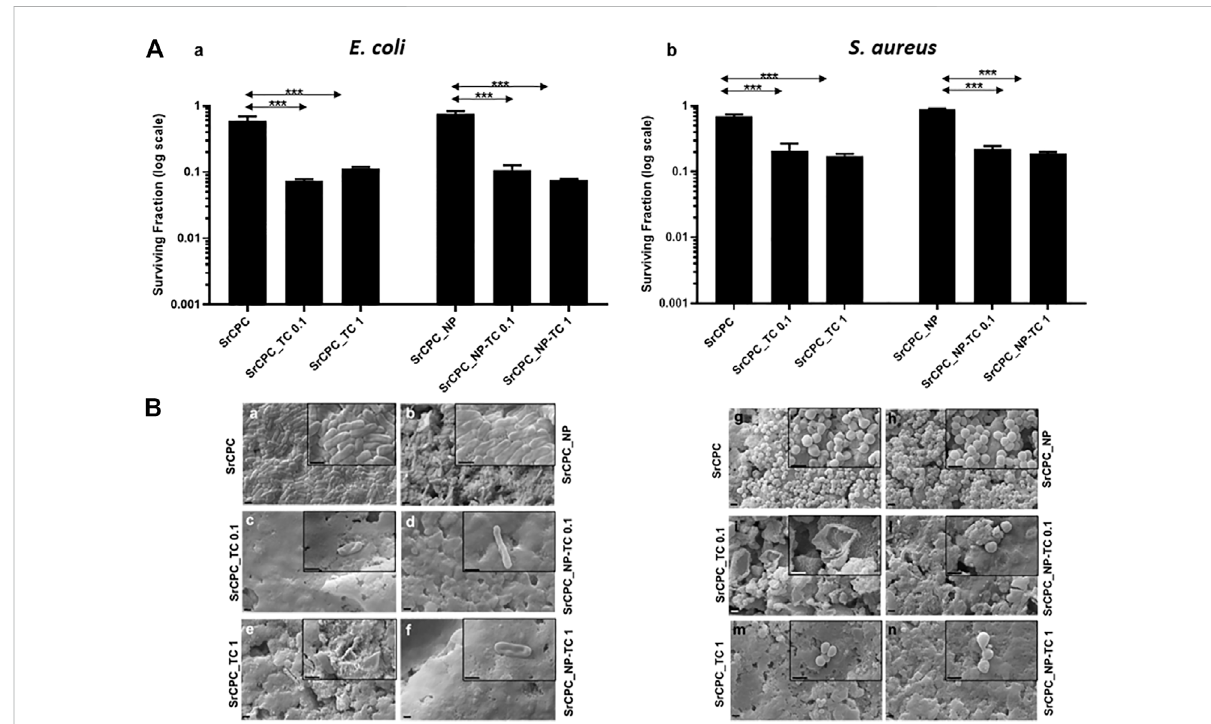
FIGURE 8 Effect of the tested scaffolds on the formation of bacterial bio fi lms (Pre-bio fi lm conditions). (A) Viability of bacterial bio fi lms. E. coli (A,a) and S. aureus (A,b) wereincubatedfor24 hat37 ° Condifferentscaffoldsinordertoallowtheformationofbio fi lmasindicatedinthematerialsandmethods section. After overnight incubation, the planktonic bacteria were removed, and the cell viability of bacterial bio fi lm formed on the scaffolds were tested with MTT. The control is represented by bio fi lm grown on tissue culture plate in LB medium as indicated in materials and methods section. The data (log scale) were represented as the surviving fraction. Bars indicate mean values SD of the mean of results from two experiments. Statistical signi fi cance between the doped apatitic bone cements of the same group and their relative undoped samples are indicated as: *** p < 0.001. Statistical signi fi cance values detected for all samples related to bacteria grown in tissue culture plate with LB medium and no scaffolds: p < 0.05 (data not shown); (B) SEM images of bio fi lm. E. coli (Ba – f) and S.aureus (Bg – n) bio fi lmswereobservedwith SEM. Images at magni fi cation